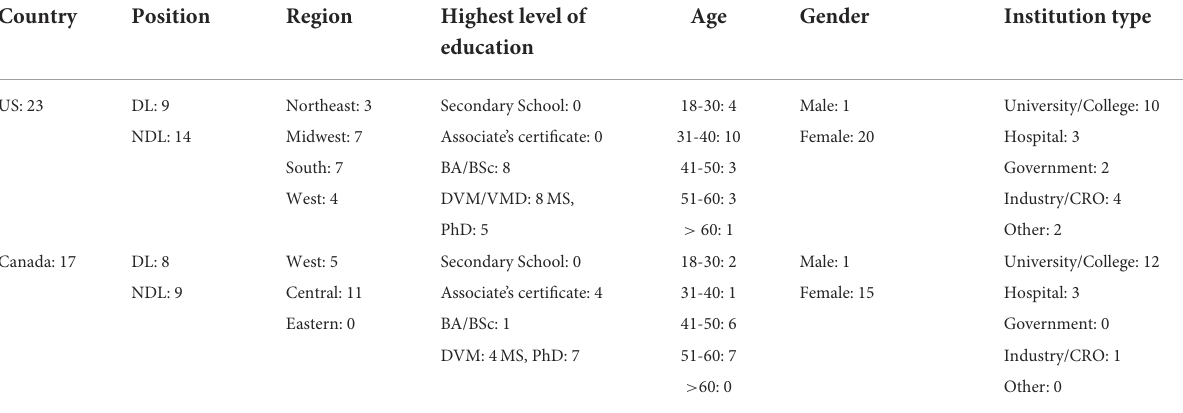
TABLE 1 Demographic information for interview participants ( n = 40).